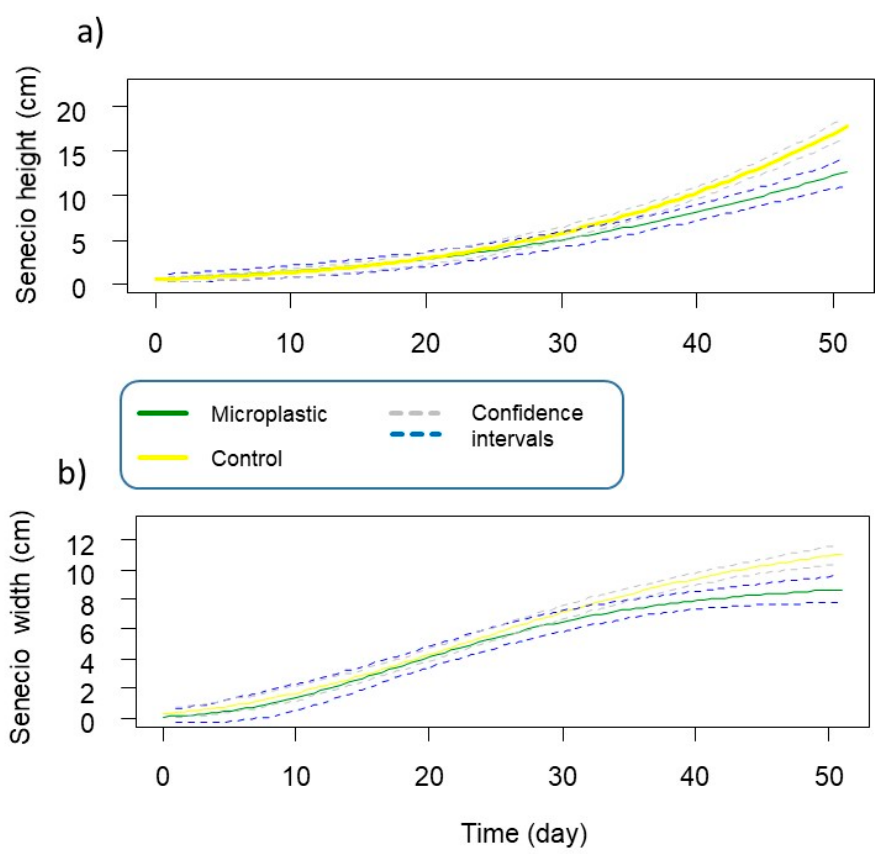
Figure 5. Gompertz growth trajectories for plant height ( a ) and width ( b ) of S. inaequidens during a period of about two months.